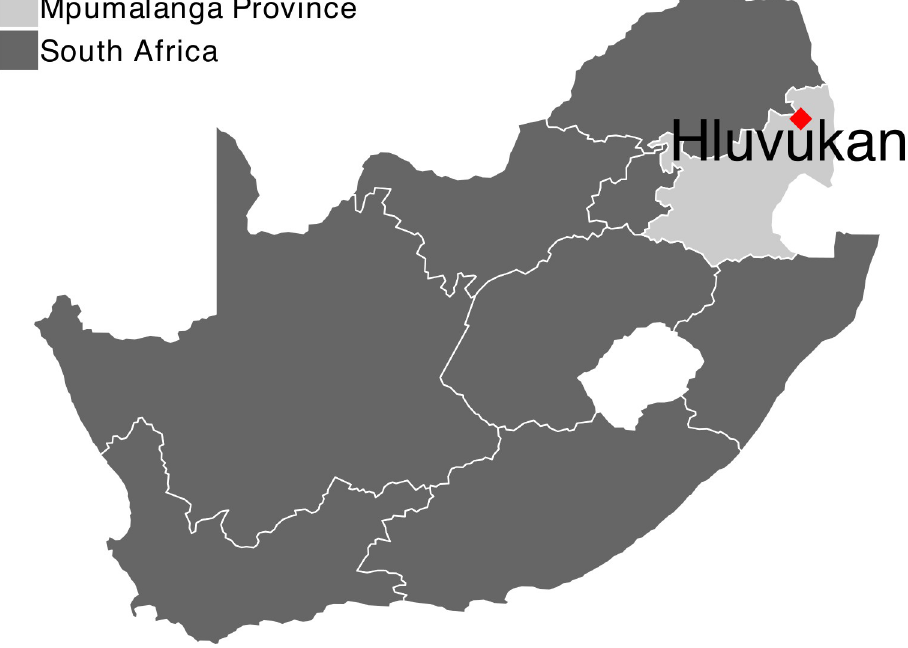
Fig 3. Location of our study area for the health and demographic surveillance system. Map produced using R gglpot and data from https://gadm.org/download_country_v3.html.